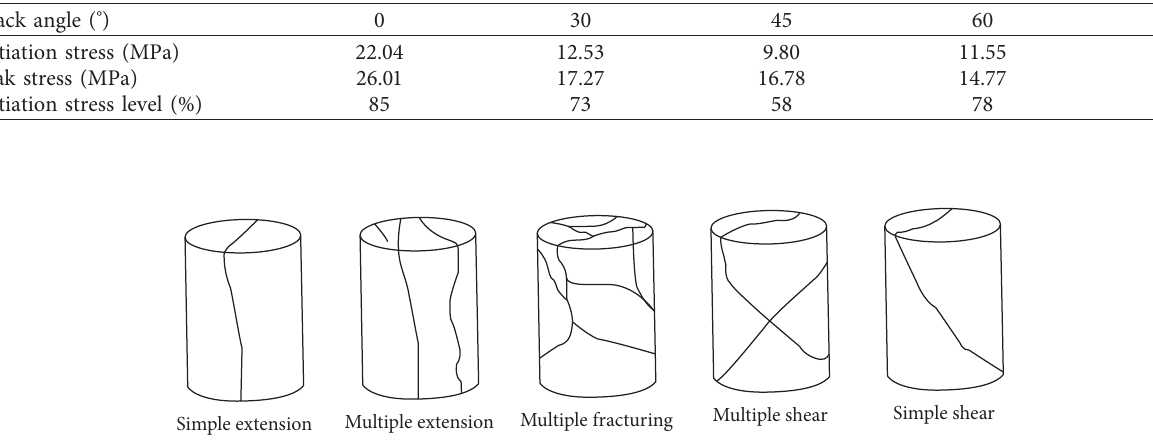
Figure 4: Classification of rock failure modes under uniaxial compression